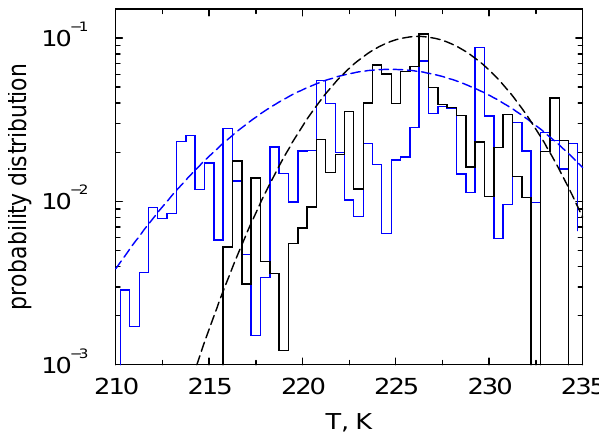
Fig. 4. Probability distributions of RHI obtained with normal dis- tributions of T and χ , assuming that both quantities are uncorre- lated. The solid black/red/blue distributions here include variations of T and adiabatic pressure changes. We use the baseline val- ues T o = 225 K, σ = 2 . 5 K, and RHI o = 50%. The dashed distribu- tions additionally include variations of χ , with the baseline value σ w = 0 . 5 χ o . Red and blue distributions assume RHI o = 20% and RHI o = 80%, respectively.